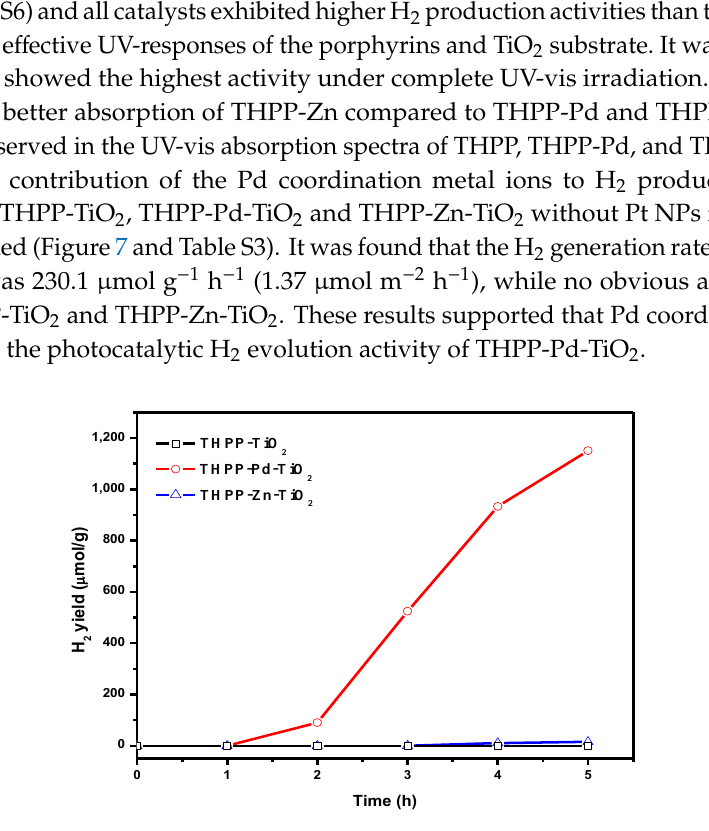
Figure 6. H 2 production curves of Pt/THPP-TiO 2 , Pt/THPP-Pd-TiO 2 , and Pt/THPP-Zn-TiO 2 in an aqueous solution of 10% TEOA under visible-light irradiation ( λ > 420 nm).